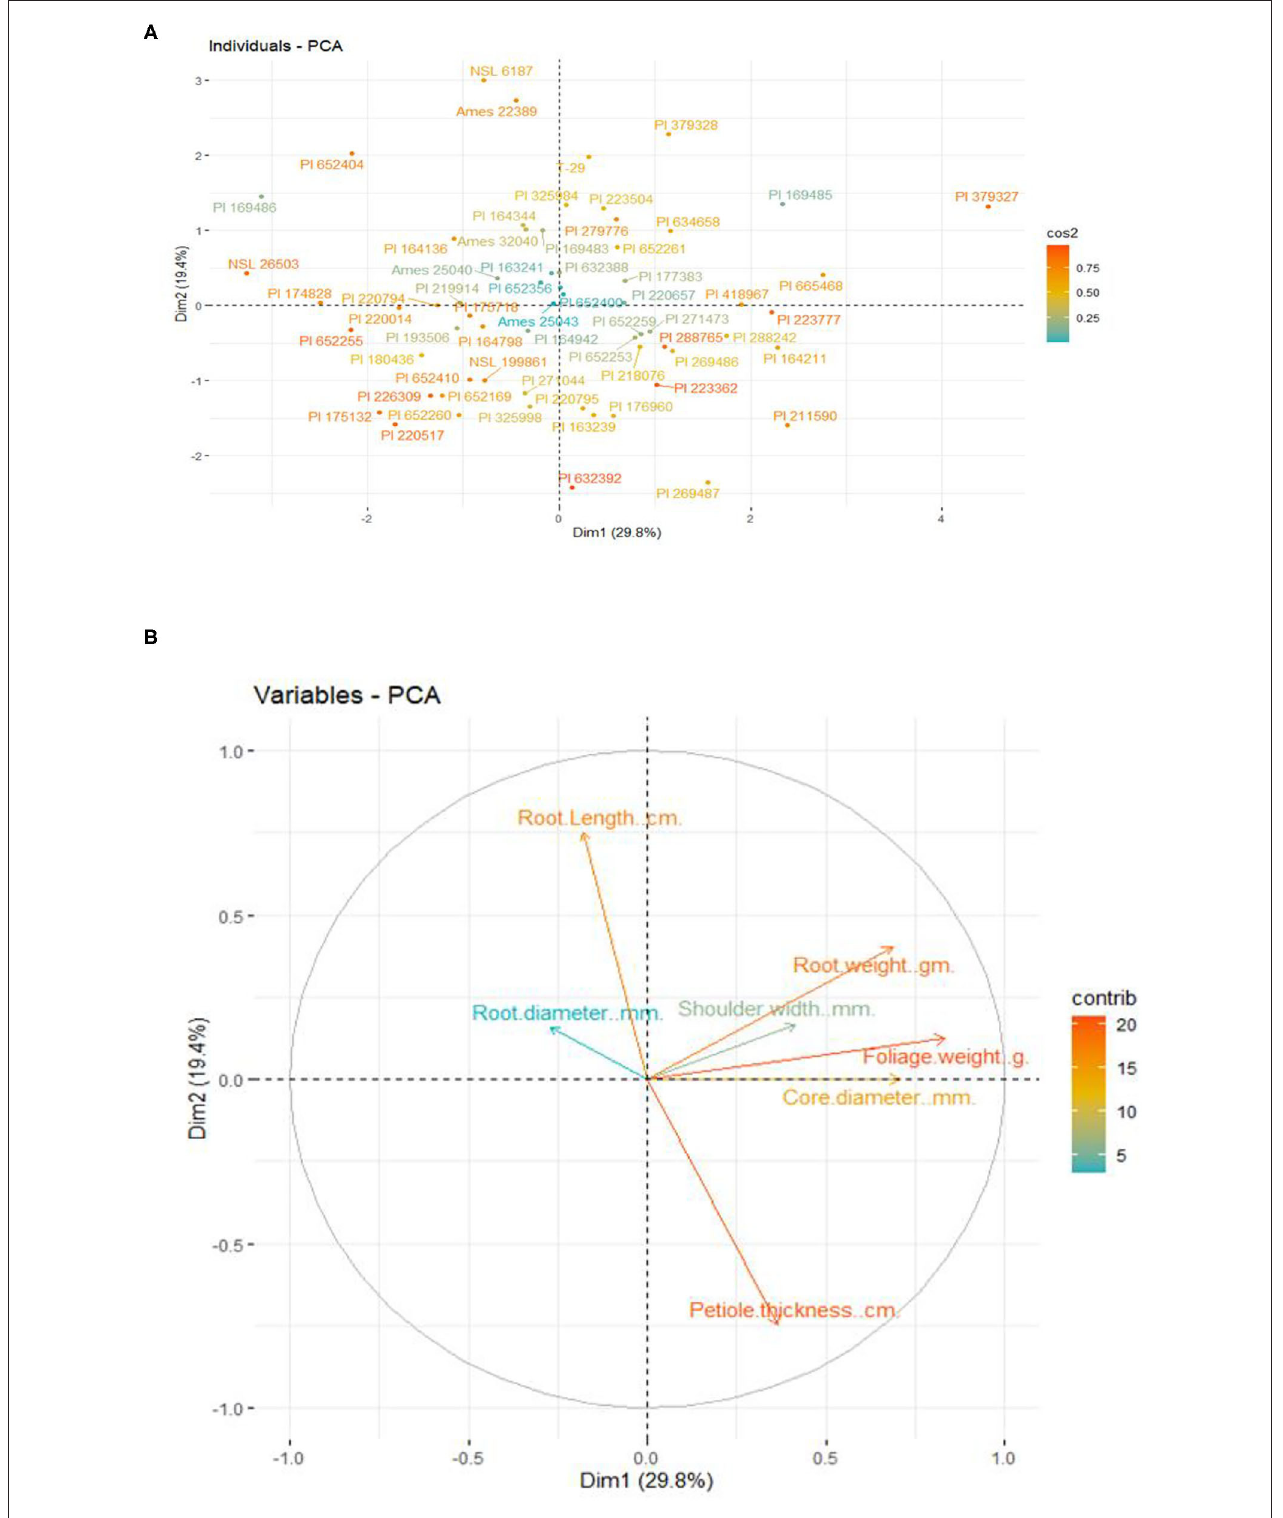
FIGURE 3 | (A) Classification of 64 Daucus carota L. genotypes for morpho-nutritional parameters based on the principal component analysis (B) . PCA analysis depicting the relationship between variables and their contribution in total variation of carrot morphological traits.